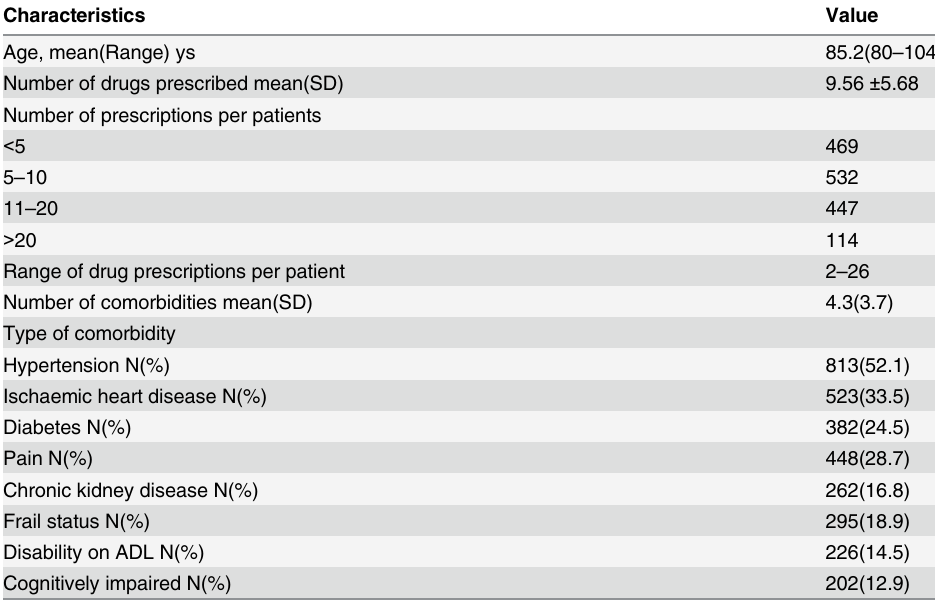
Table 1. Baseline characteristics of the study population (n =